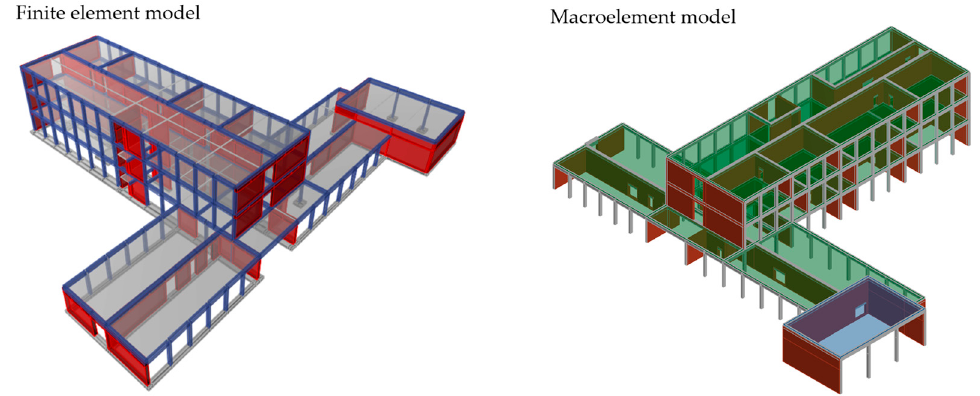
Figure 7. Numerical models of the building.